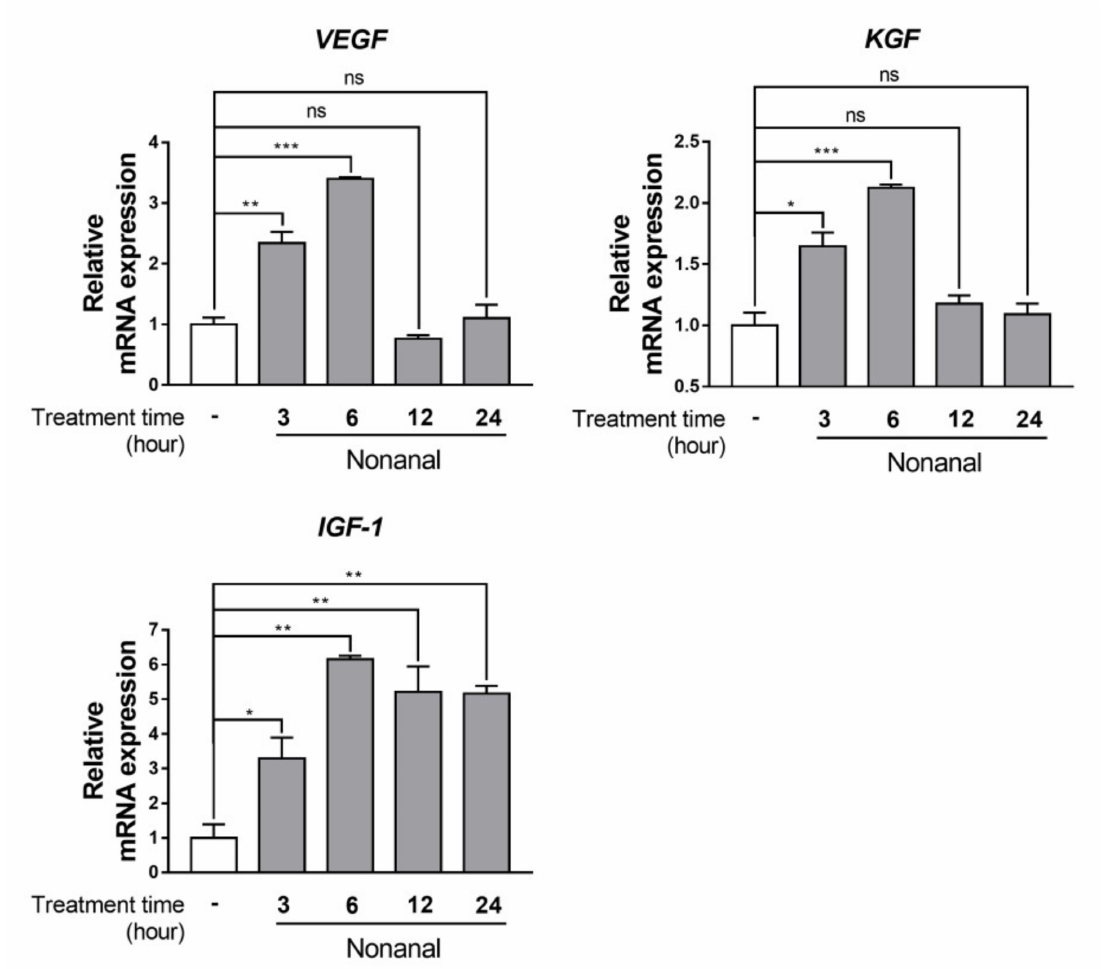
Figure 2. The time-course of mRNA expression of growth factors in response to nonanal treatment in DPCs. DPCs were treated with vehicle or 50 µ M nonanal and the relative mRNA levels of growth factors were measured by real-time PCR over a 24 h time-course. Data were statistically analyzed using the Student’s t -test. Data are presented as mean ± SEM of the results of three independent experiments. * p < 0.05, ** p < 0.01, *** p < 0.001. ns, not